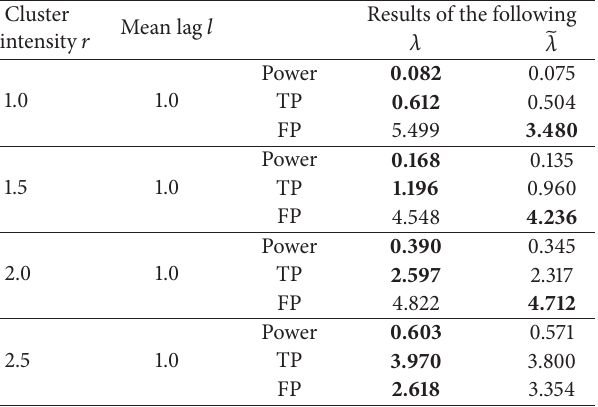
Table 3: Heterogeneous Gaussian